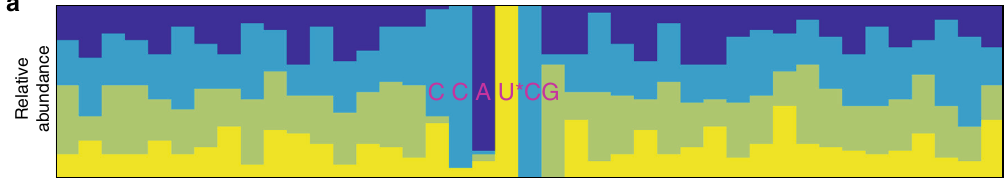
Next, we sought to develop a strategy to detect and quantify A3A- generated RNA mutations in tumors. Droplet digital PCR (ddPCR) is a quantitative and sensitive method to detect SNPs, rare muta- tions, copy number variations, and gene rearrangements. ddPCR is